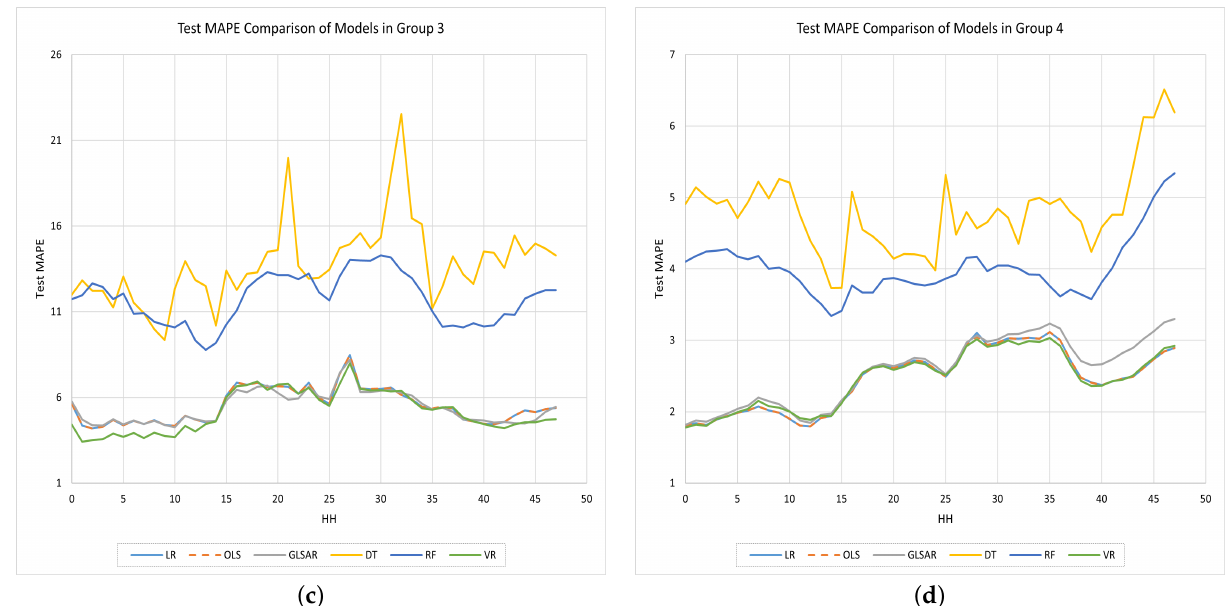
Figure 7. Comparison of the test MAPE values obtained by each half-hourly model in each